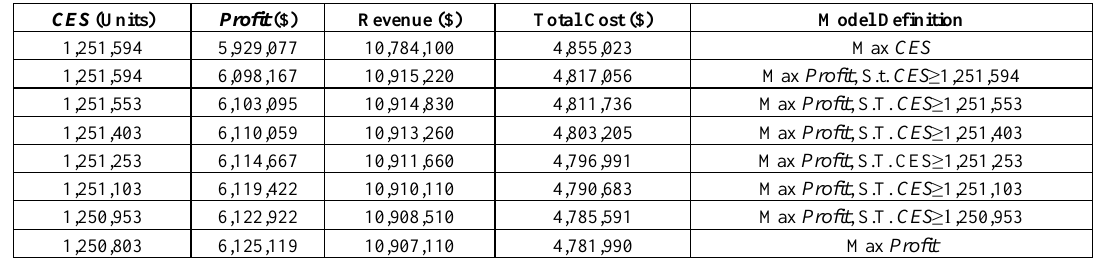
Table 7. Variation of Profit with the variation of